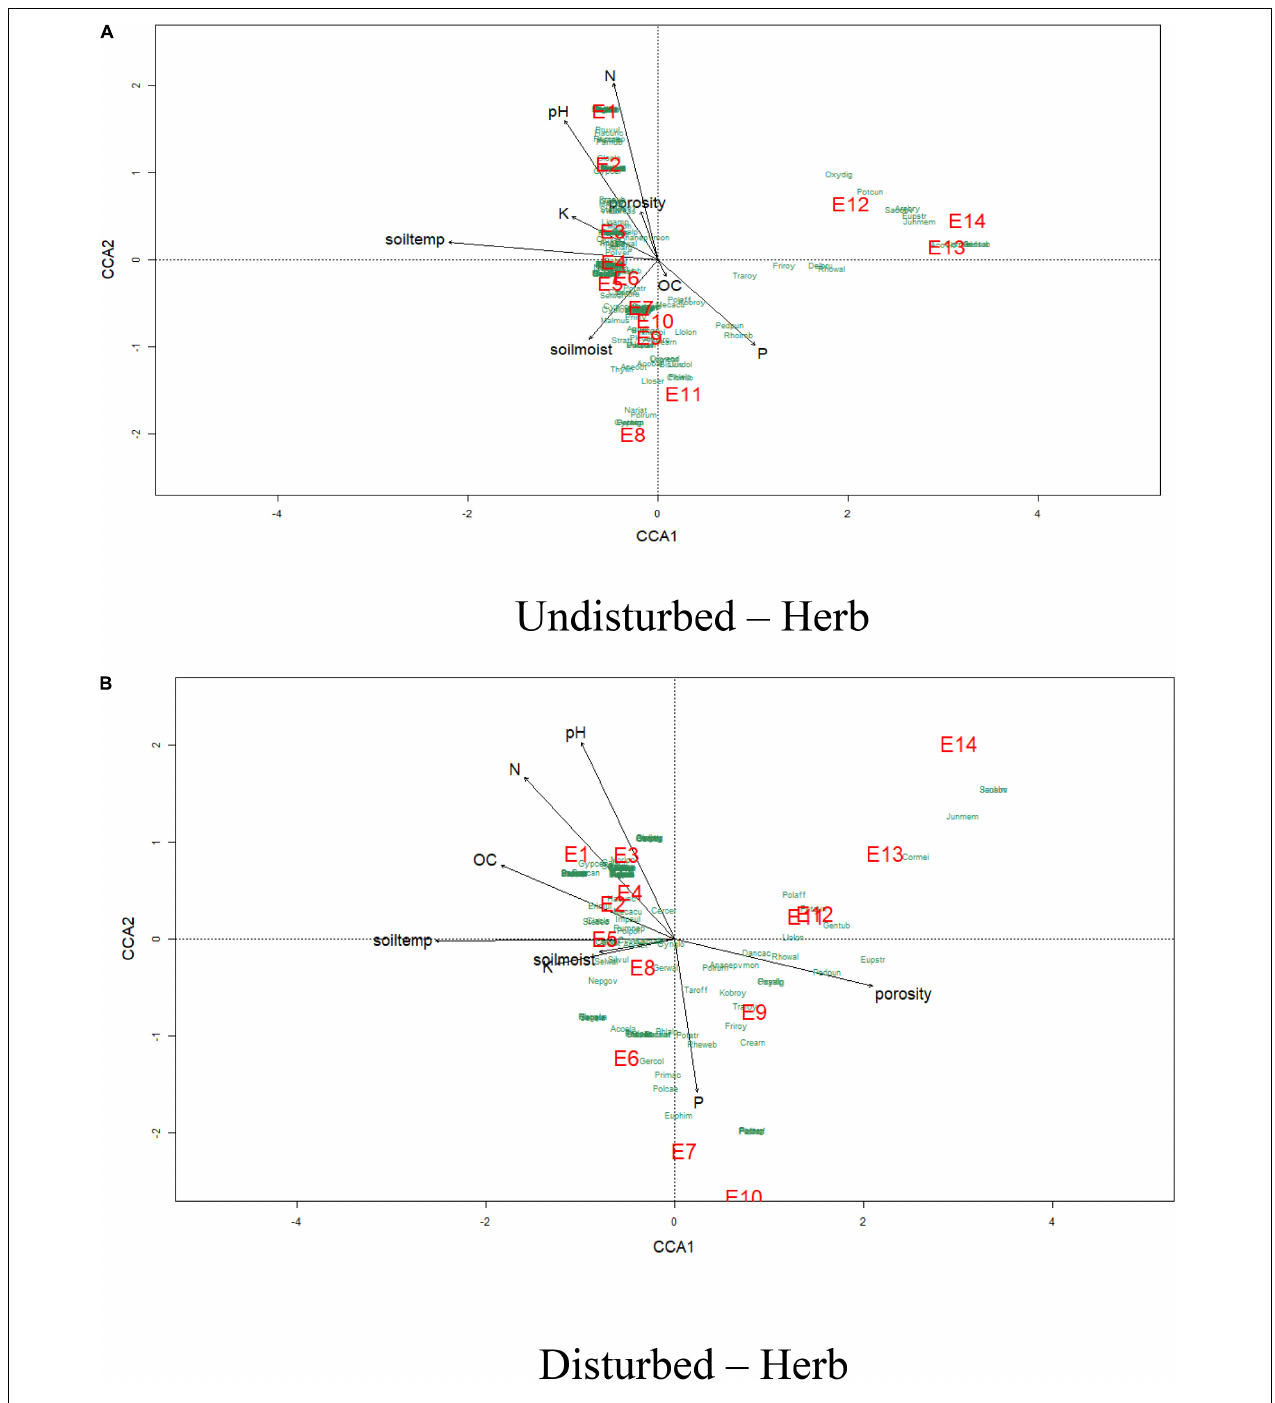
FIGURE 9 | Canonical correspondence analysis of vegetation abundance and elevation (represented by E) overlaid to soil parameters at a p.max = 0.25 for undisturbed and disturbed quadrates of herbs in VoFNP.